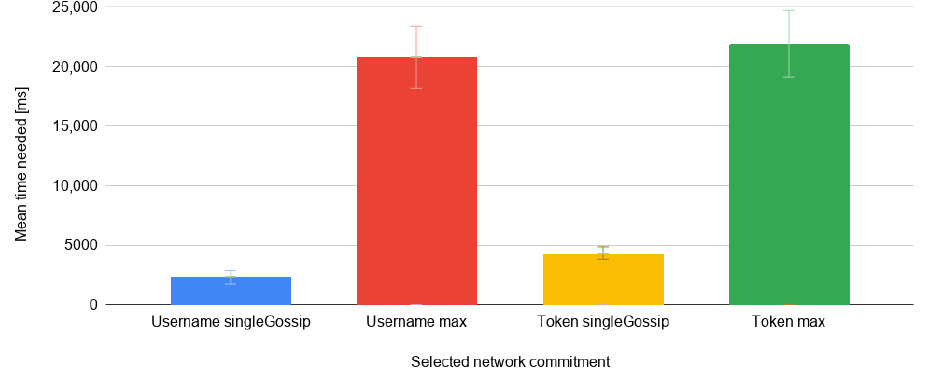
Figure 5. Registered users and tokens query